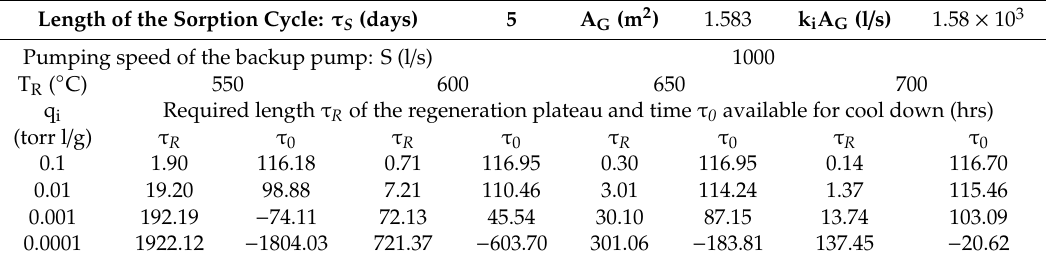
Table 7. Regeneration and cool-down times of ST707 for S = 1000 l / s and τ S = 5 days.